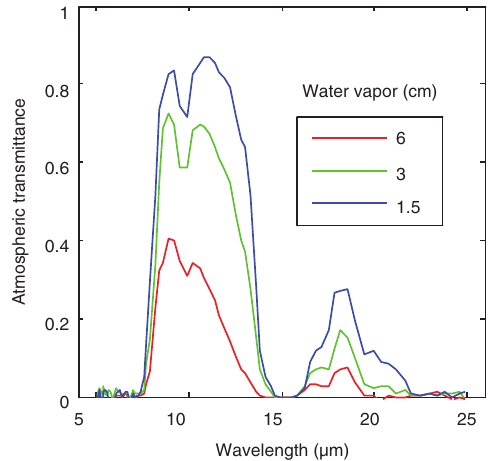
Figure 2: The computed atmospheric transmittance spectrum, computed using the Lowtran model. The temperature of the lowest kilometer of atmosphere is assumed to be 21 ° C, the ozone content assumed to be 0.35 atm · cm, and aerosols are of urban type with a 23 km visual range. Different precipitable water vapor levels are shown as red, green, and blue curves in the figure. These results have been adapted and replotted from